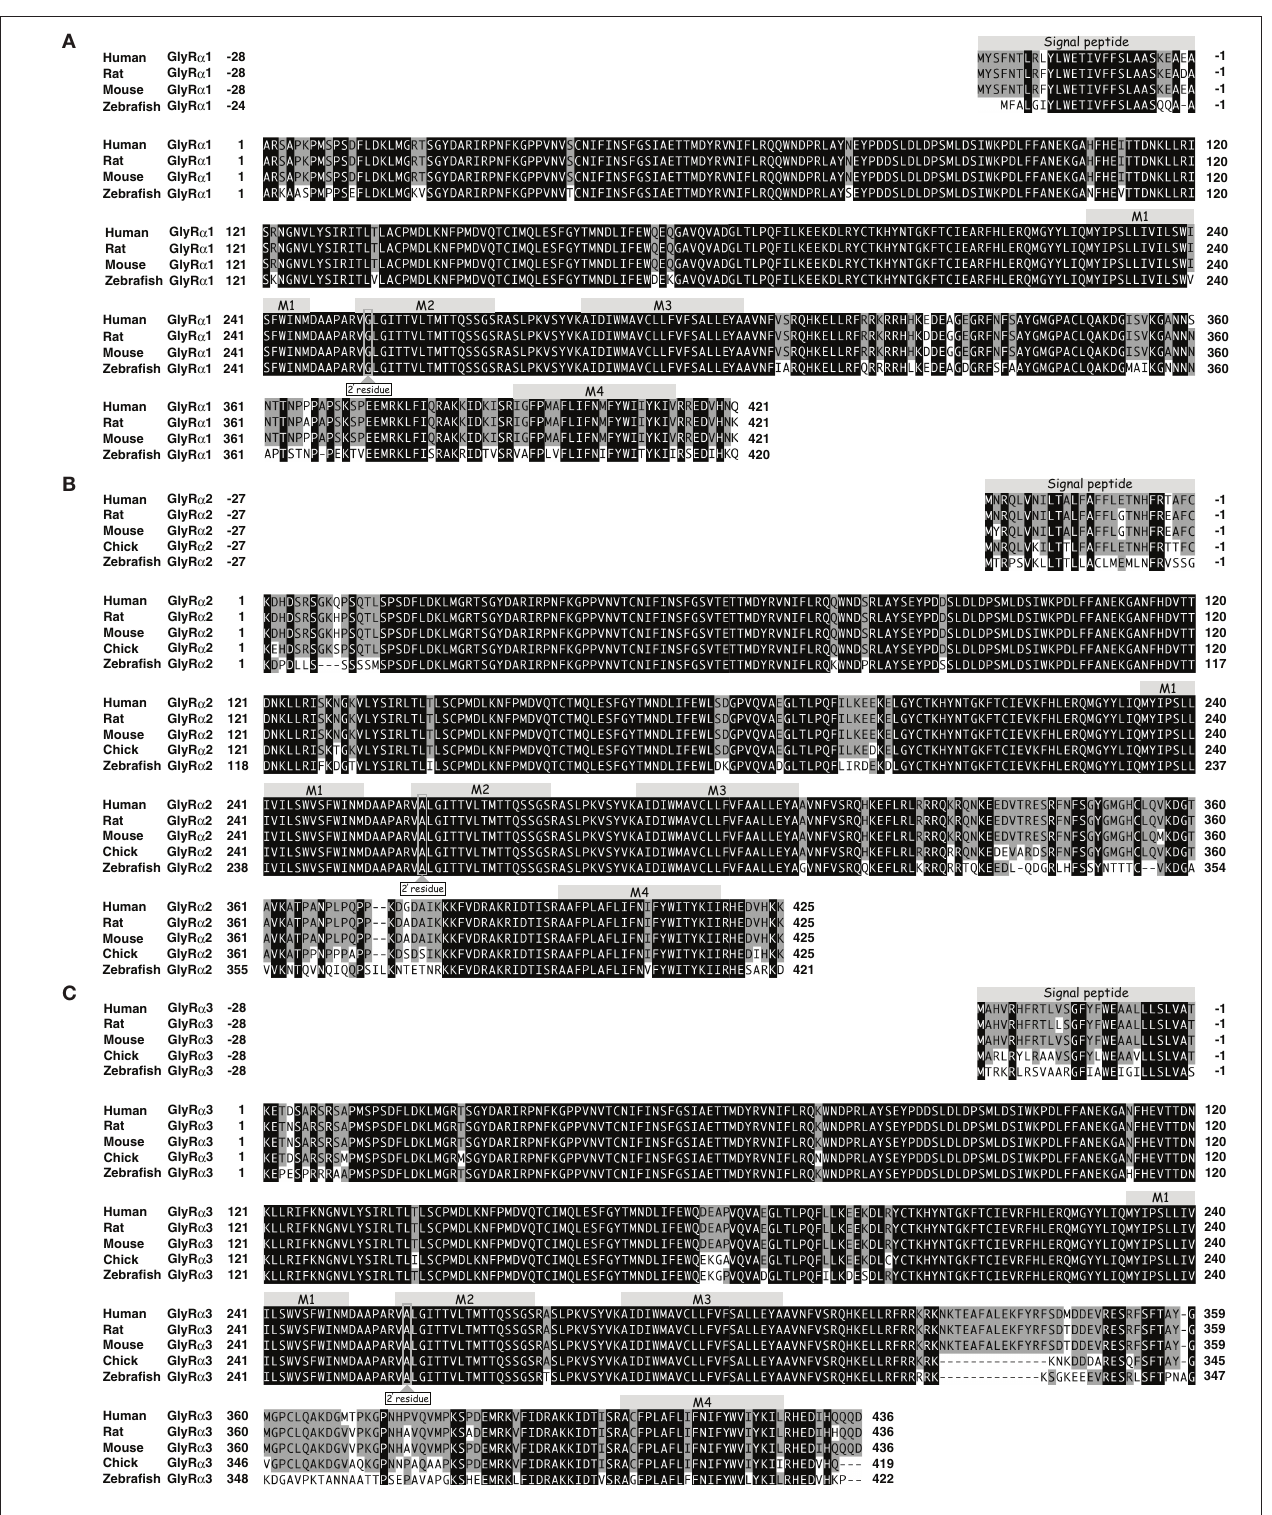
FIGURE 3 | Sequence alignments of zebrafi sh GlyR subunits with avian and mammalian counterparts. (A) Sequence alignment of human (GenBank accession: NP_000162), rat (NP_037265), mouse (NP_065238) GlyR α 1 with zebrafi sh (NP_571477) GlyR α 1. The four membrane-spanning domains are represented as M1-M4. The 2’ residues in M2 are highlighted by grey box. Signal